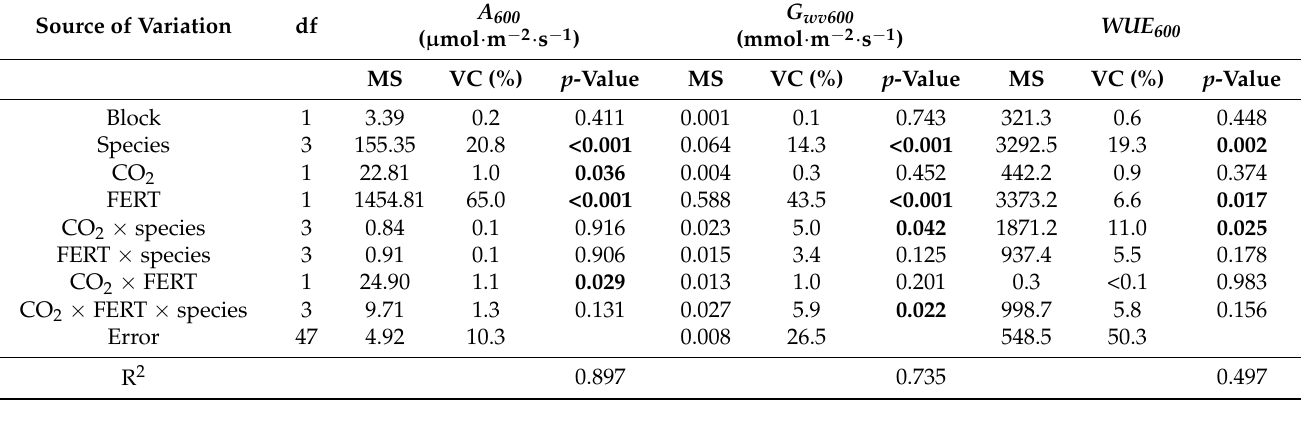
Table 7. Gas exchange traits and ANOVAs from the CO 2 x fertilizer treatment experiment, 2018, including source of variation, degrees of freedom (df), mean square values (MS), variance components (VC), p -values, and coefficient of determination ( R 2 ). p -values <0.05 are in bold print.